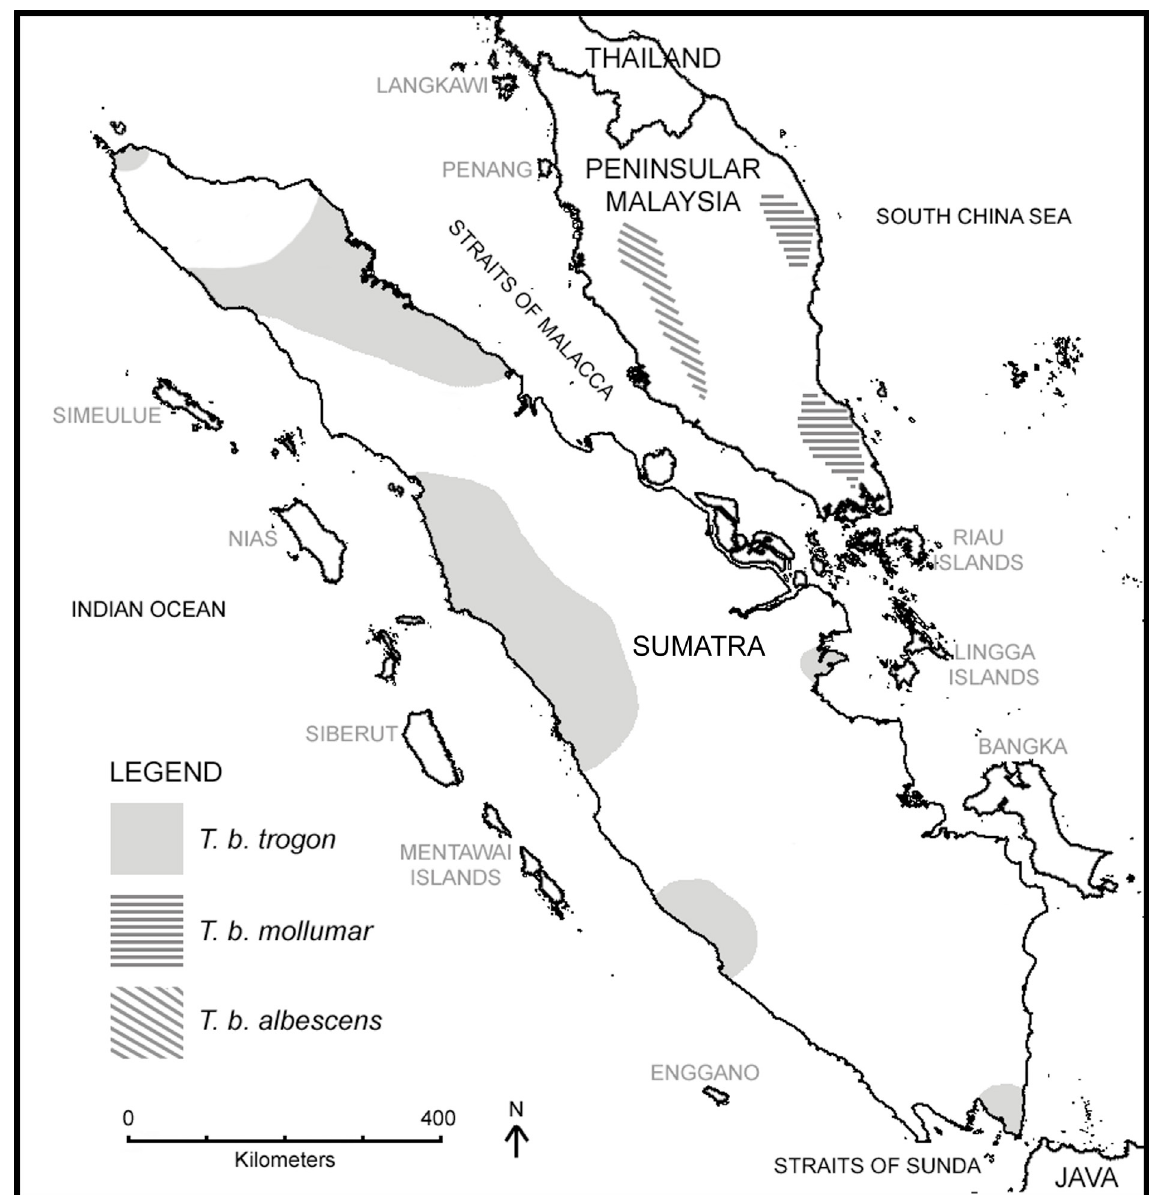
Fig. 1. Distribution map of Trogonoptera brookiana (Wallace, 1855) subspecies albescens (rothschild, 1895), mollumar d’Abrera, Doggett & Parker, 1976 and trogon (Vollenhoven, 1860). ranges are based on localities given in specimen labels and the literature, where georeferencing was